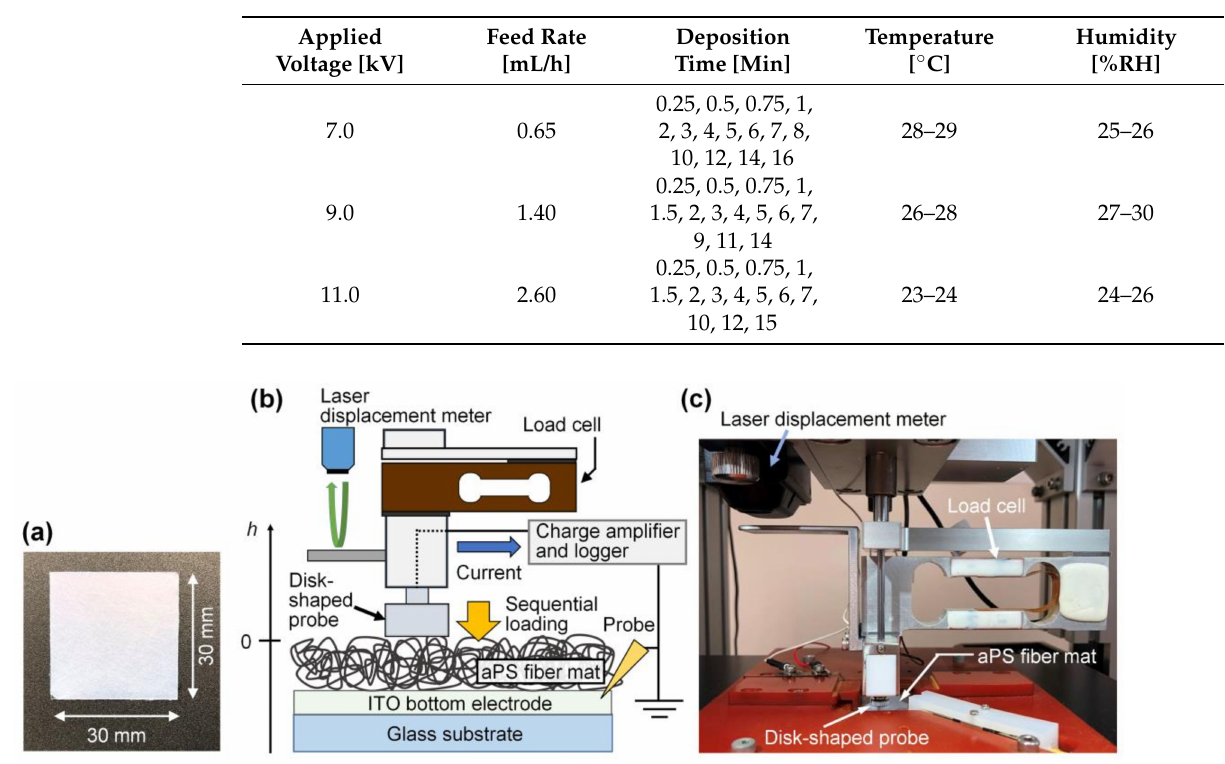
Figure 1. ( a ) Photograph of the entire as-electrospun aPS fiber mat on the ITO/glass substrate. ( b ) A schematic of the sequential approaching/loading technique using the piezoelectric constant measurement apparatus. ( c ) A photograph of the